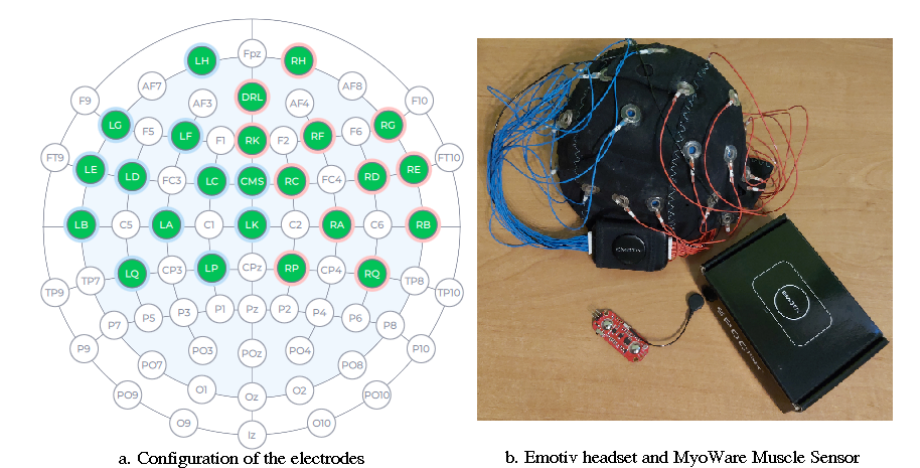
Figure 1. Data acquisition, analysis and classification system.